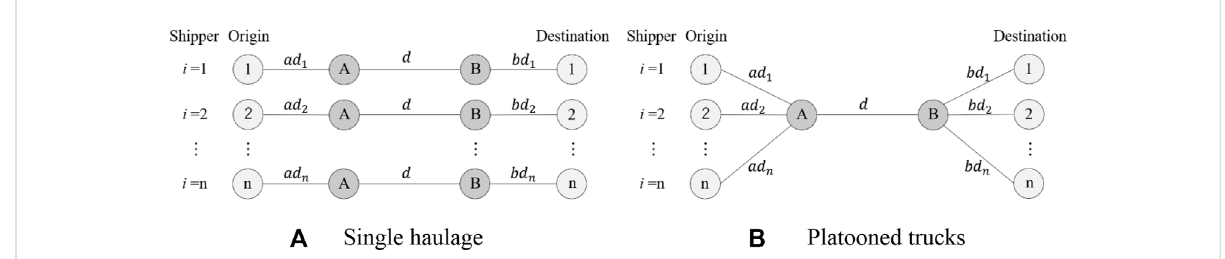
FIGURE 1 Hypothetical networks of single and truck platooning haulage. (A) Single haulage, (B) Platooned